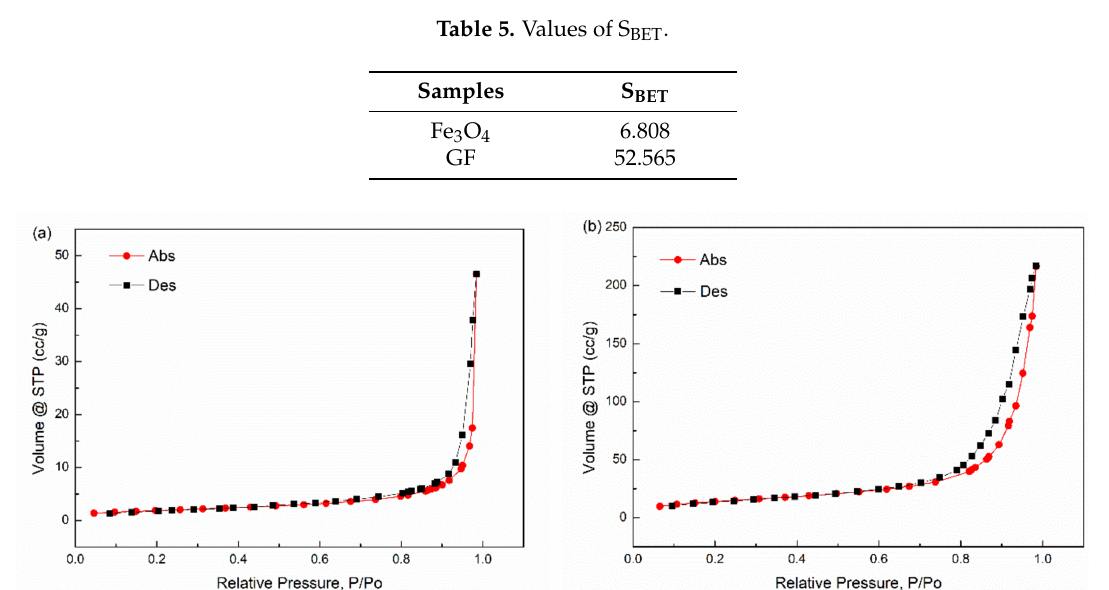
Figure 9. Spectra of nitrogen absorption and desorption trends for BET. ( a ) Fe 3 O 4 ; ( b )